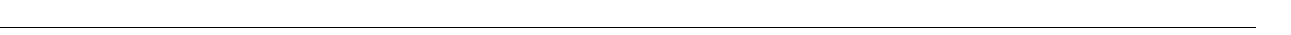
Figure 6 | IR mechanism sustained in in vivo xenograft model, ex vivo primary MCL specimens and recapitulated in drug screening assay. ( a ) Xenograft experiments showed that HK cells enhanced tumour formation of both parental (Sen) and IR MCL cells (HBL-2). IR MCL cells had more robust tumour formation in vivo compared with parental cells. * P o 0.05, n ¼ 5 per cohort (Student’s t -test). ( b ) Immunoblot and flow cytometry conducted on MCL samples from NOD/SCID mice injected with HBL-2 cells and IR HBL-2 with and without co-injection of HK cells of cohorts as described in a . 1–8 represent eight xenografts, with relative expression of pAKT and p-4EBP were quantitated by quantitative densitometry and shown in coloured bar graph. ( c ) Immunohistochemistry stains showing elevated AKT activation ( c ) and b 1 expression ( d ) in IR MCL patient samples when compared with ibrutinib- sensitive samples or samples on the progression after ibrutinib treatments. Scale bar, 10 m m. ( d ) A cell-based drug screening assay was used to measure cell growth and chemosensitivity to indicated chemical agents in a reconstructed TME. Parental and IR cells (SP49-Sen and SP49-IR) were seeded in 384- well plates of reconstructed bone marrow, including high physiological cell densities (1–10 (cid:3) 10 6 cells per ml), extracellular matrix (collagen 1) and human bone marrow derived stromal cells (BMSC). A panel of drugs at five different concentrations was added to the media, and plates were continuously imaged for 96h using a digital image analysis algorithm to identify viable cells based on membrane motion (pseudo-coloured in green). Changes in viability are quantified by area under curve (AUC). Left, cell growth and viability of sensitive (Sen) and IR MCL cells was measured with no treatment, treatment with ibrutinib, doxorubicin, MK2206 or INK128; right, images at 48h in these conditions. Negative controls (no drug) were included, as well as positive controls for each drug (cell line MM1.S at highest drug concentration). Scale bar, 30 m m. ( e ) Heat map showing chemosensitivity of parental (Sen) and IR cells (Resis) to 31 agents including protein kinase inhibitors, inhibitors of enzymatic processes and chemotherapeutic agents. See also Supplementary Figs 6, 8 for full gel scan of the